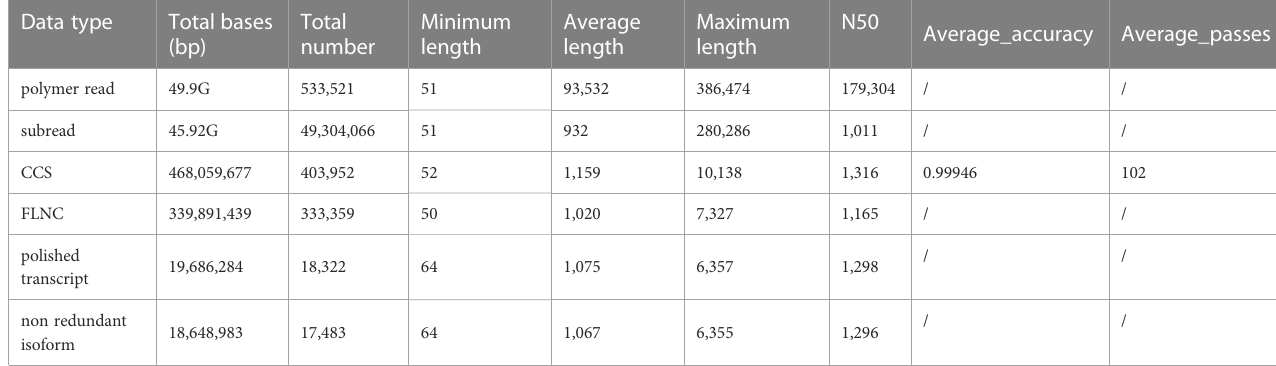
TABLE 1 Statistics of sequencing data and transcript clustering